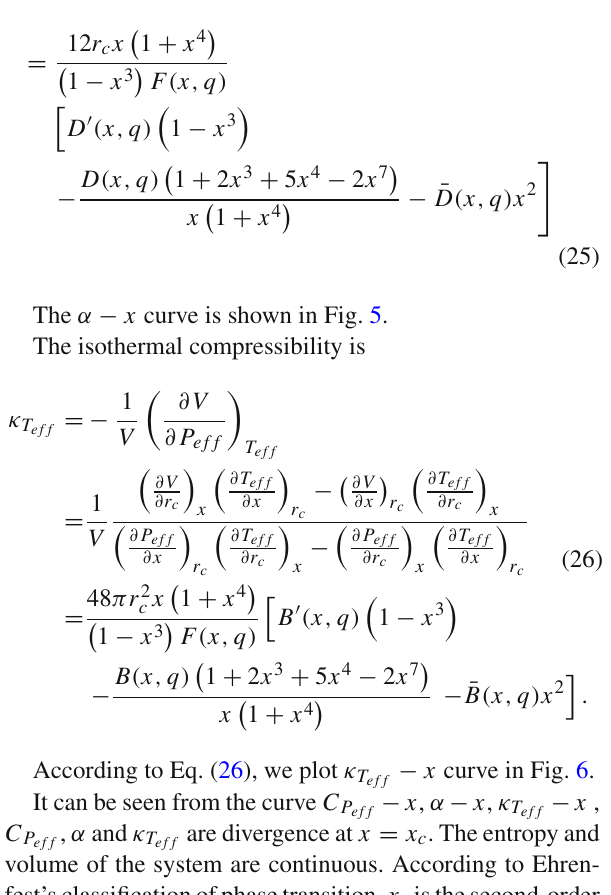
− x diagrams when the parameters change respectively and the initial parameters m = 2 . 12, c Fig. 4 C P eff k =